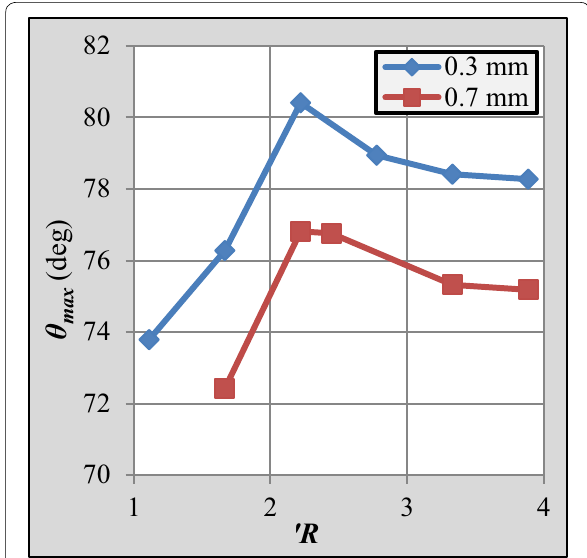
Figure 3 Formability curves at varying step size